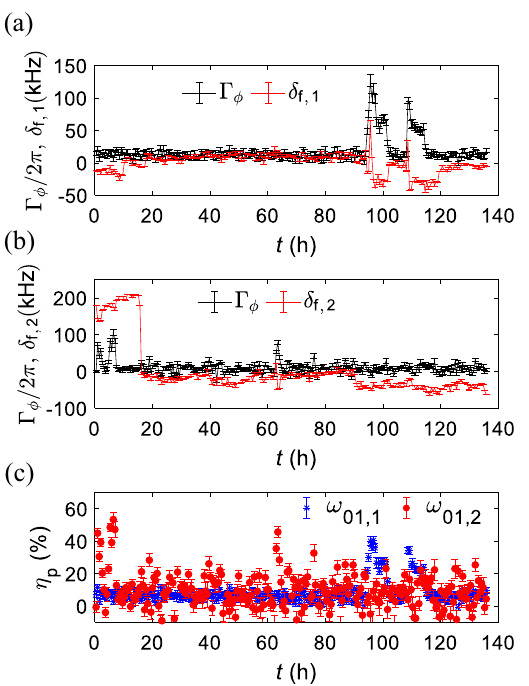
Fig. 5 Fluctuations of the pure dephasing rate, the qubit frequency, and the quantum-ef fi ciency reduction of the single- photon source. a , b Fluctuations on the pure dephasing rate Γ ϕ and the qubit frequency around ω 01,1 /(2 π ) = 5.51 GHz and ω 01,2 /(2 π ) = 5.39 GHz, corresponding to 0 and 120 MHz detunings, over 136 h. c Fluctuations of the reduction of the quantum ef fi ciency, η p , due to the fl uctuations of Γ ϕ at 0 MHz and 120 MHz detunings, over 136 h. In all panels, the error bars are two standard deviations.